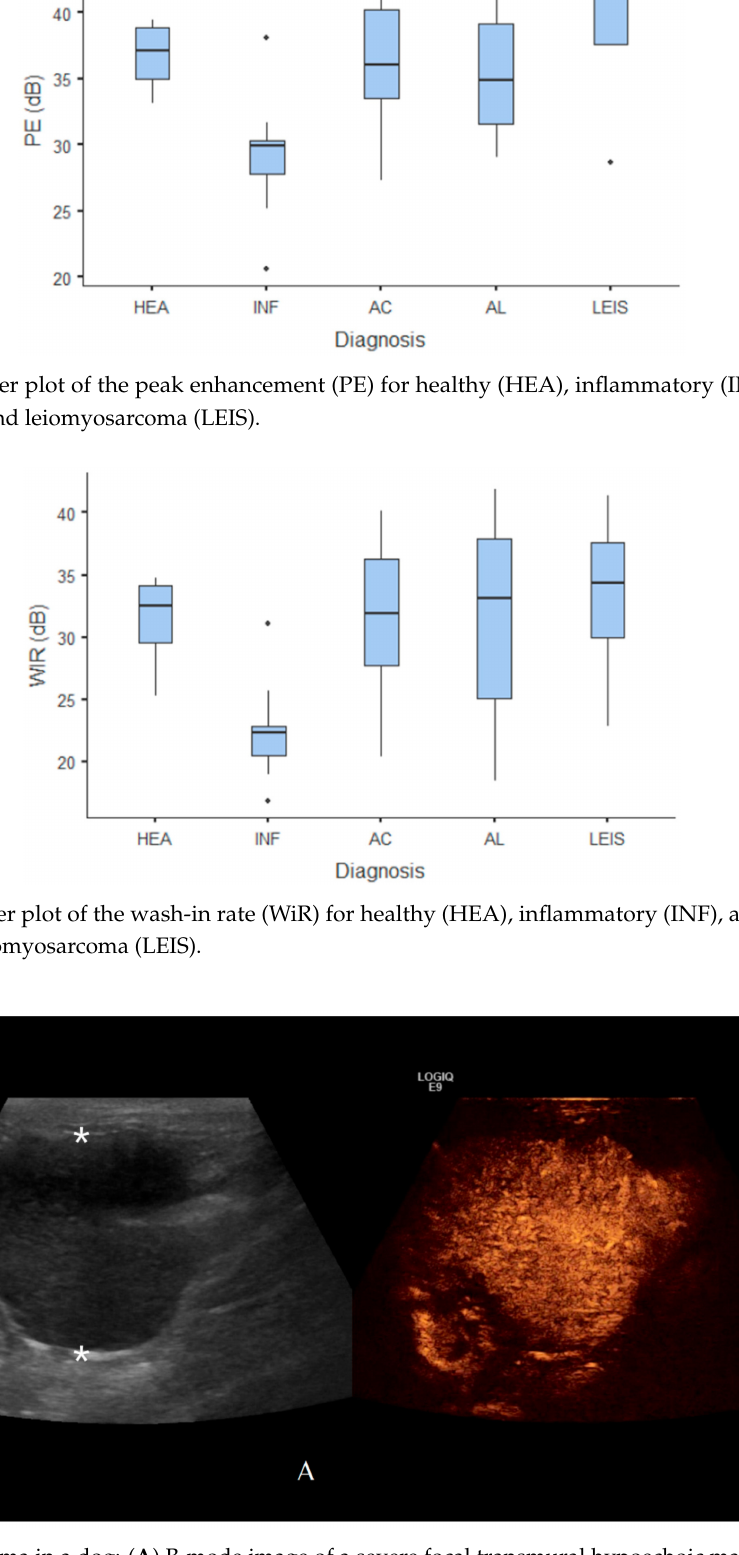
Figure 9. Gastric lymphoma in a dog: ( A ) B-mode image of a severe focal transmural hypoechoic mass of 24 mm (between asterisks) with absent layers definition; ( B ) contrast enhanced ultrasound (CEUS)examination of the same gastric mass during the peak enhancement (17 s) of the time-intensity